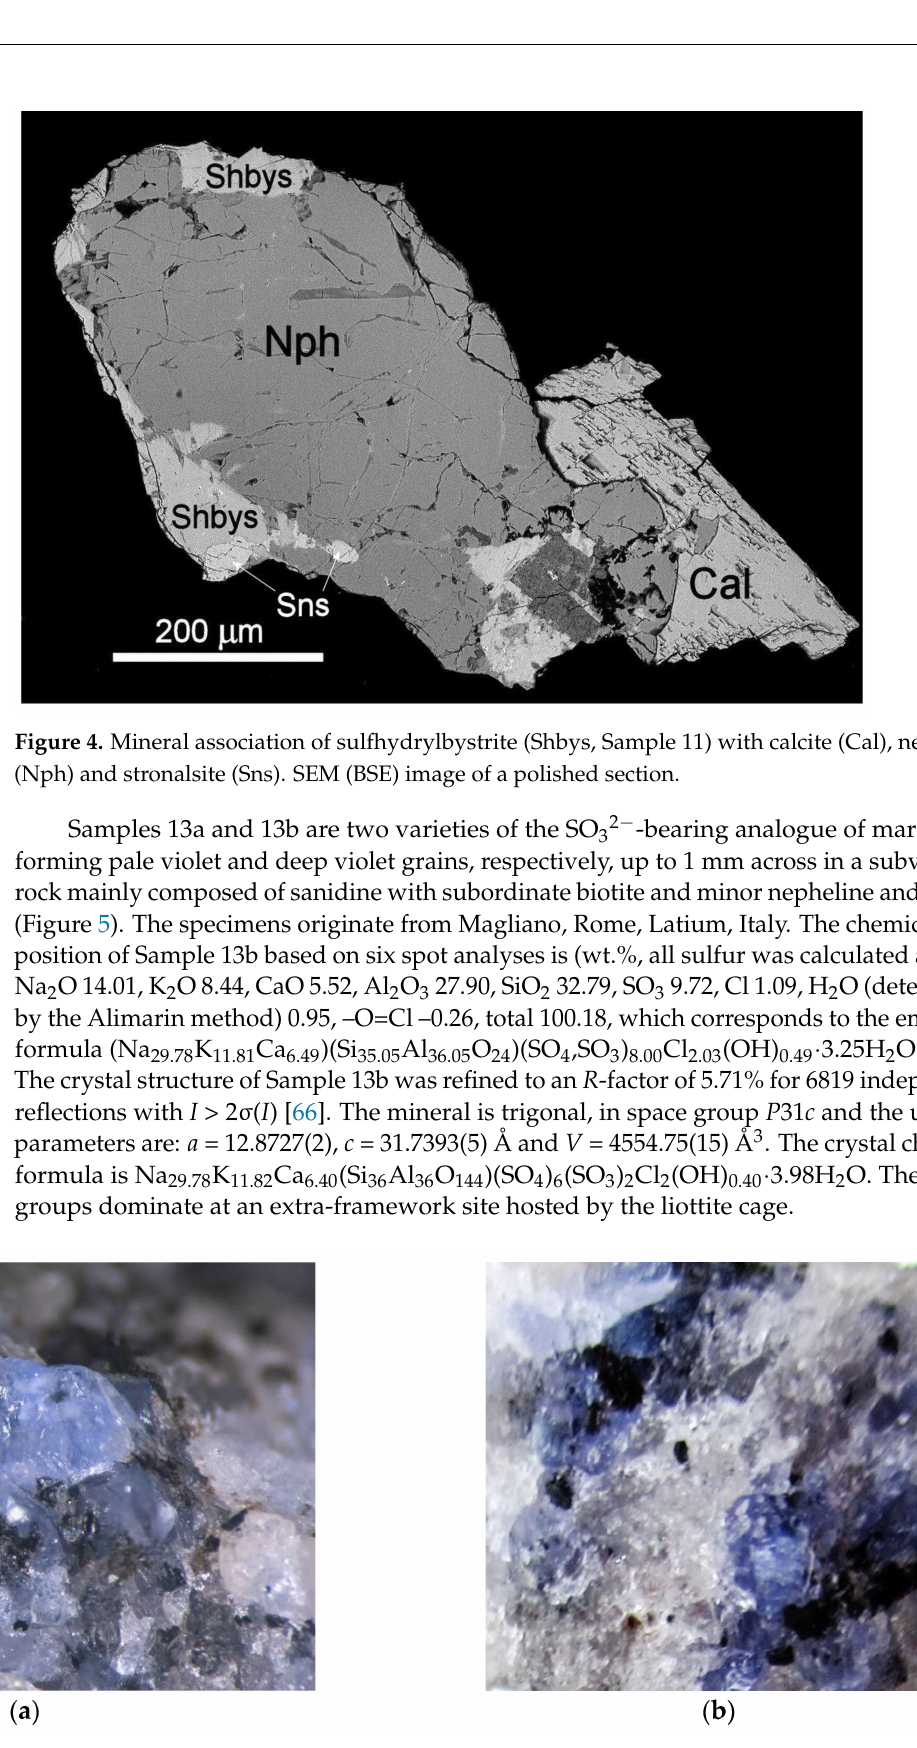
Figure 5. Grains of the SO 3 2 − -bearing analogue of marinellite in association with sanidine (white) and biotite (black): Samples 13a ( a ) and 13b ( b ). Field of view widths: 3 mm ( a ) and 5 mm ( b